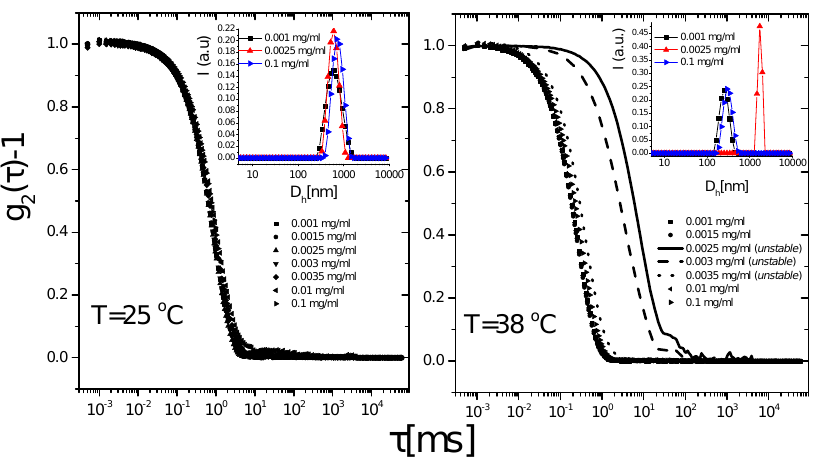
Figure 7. Intensity autocorrelation functions g 2 ( τ ) -1 for P α 50/m1-KPS mixtures at selected C PLL (see panels) and two temperatures, 25 ◦ C (Left panel) and 38 ◦ C (Right panel), representing the neutral- like and the charged-like behavior of PNIPAm microgels. A reentrant shift to much longer relaxation times of the correlograms appears only at high temperatures ( T > T c ), while it is absent for T < T c . The inset panels show the intensity-weighted size distributions obtained by CONTIN analysis of the correlograms for three selected P α 50 concentrations, correspondent to poorly P α 50-decorated microgels, nearly neutralized microgels and overcharged